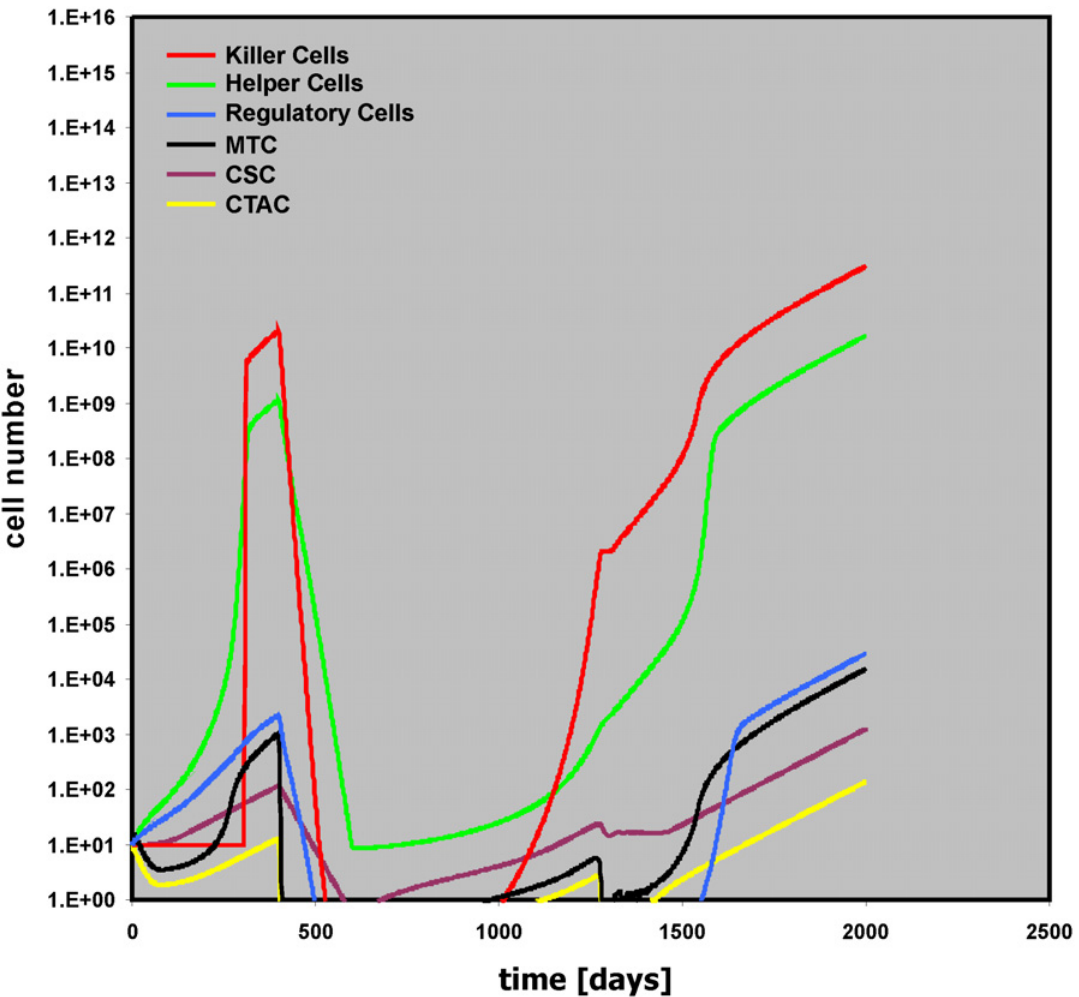
Fig 9. Late relapse due to increased therapy related toxicity for “ Killer Cells. ” In this simulation, the duration of cytotoxic therapy was increased from 100 to 200 days (for all cell types). Intensity of cytotoxic therapy against mature tumor cells and transit amplifying cells was high (MTC THx intens = CTAC THx intens = 0.9), but cytotoxic therapy against cancer stem cells was low (CSC THx intens = 0.035). Therapy related toxicity for “ Killer Cells ” was increased (Killer THx intensity = 0.2) compared with toxicity for other bystander cells (Helper THx intens = Regulator THx intens =